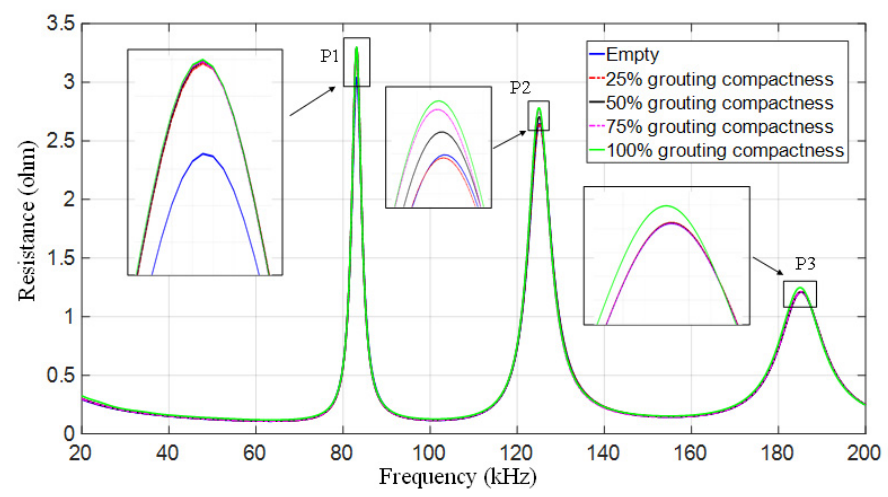
Figure 11. Simulated impedance signatures for different grouting compactness.